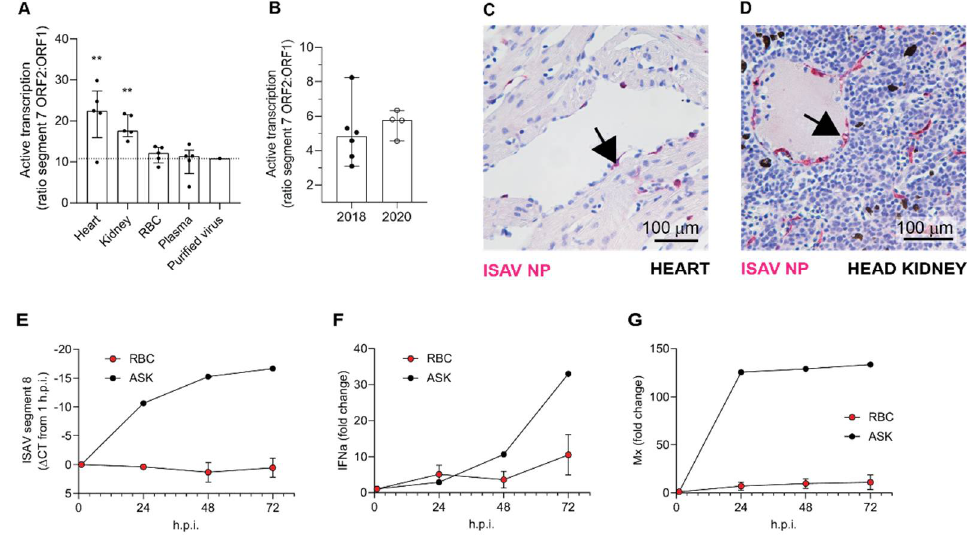
Figure 6. ISAV predominantly replicates in endothelial cells of solid organs. ( A , B ) Active viral transcription was estimated by calculating the ratio between ISAV segment 7 mRNA and RNA. Dots show values in individual fish, bars show median and interquartile ranges. ( A ) ISAV transcription in heart and kidney was higher than in RBC, plasma, and purified ISAV (13 d.p.i., 2020 trial). Stars indicate the difference between active transcription in RBC compared to heart (** p = 0.0087) and head kidney (** p = 0.0079), Mann–Whitney U. ( B ) ISAV transcription in full blood from fish harvested 12 and 13 d.p.i. in the 2018 trial (2018) and in erythrocytes harvested 13 d.p.i. in the 2020 trial (2020), detecting no significant difference between trials. ( C , D ) Micrographs showing immunostaining for ISAV nucleoprotein (NP, magenta) in formalin-fixed paraffin-embedded heart ( C ) and head kidney ( D ) from fish harvested 13 d.p.i. in the 2020 trial. Arrows point to ISAV NP-positive endothelial cells. Scalebars are 100 µ m. ( E – G ) RBC from healthy fish were infected ex vivo with ISAV and harvested 1, 24, 48, and 72 h post infection (h.p.i.). qPCR was used to measure ( E ) ISAV segment 8, ( F ) IFNa, and ( G ) Mx transcripts. ELF-1 α was used as reference for calculating fold change in F and G by the ∆∆ CT method. The graphs show means +/ − standard deviations from RBC from 4 individual fish. A representative time curve of results from infected ASK cells is included as